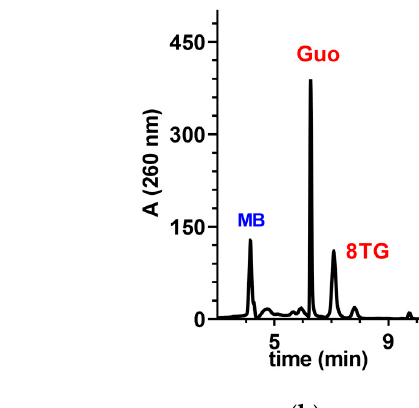
Figure 4. ( a ) UV absorption spectra recorded in the course of radiation of methylene blue (MB) and 8-TG with λ > 400 nm; ( b ) Chromatogram of the irradiated mixture.